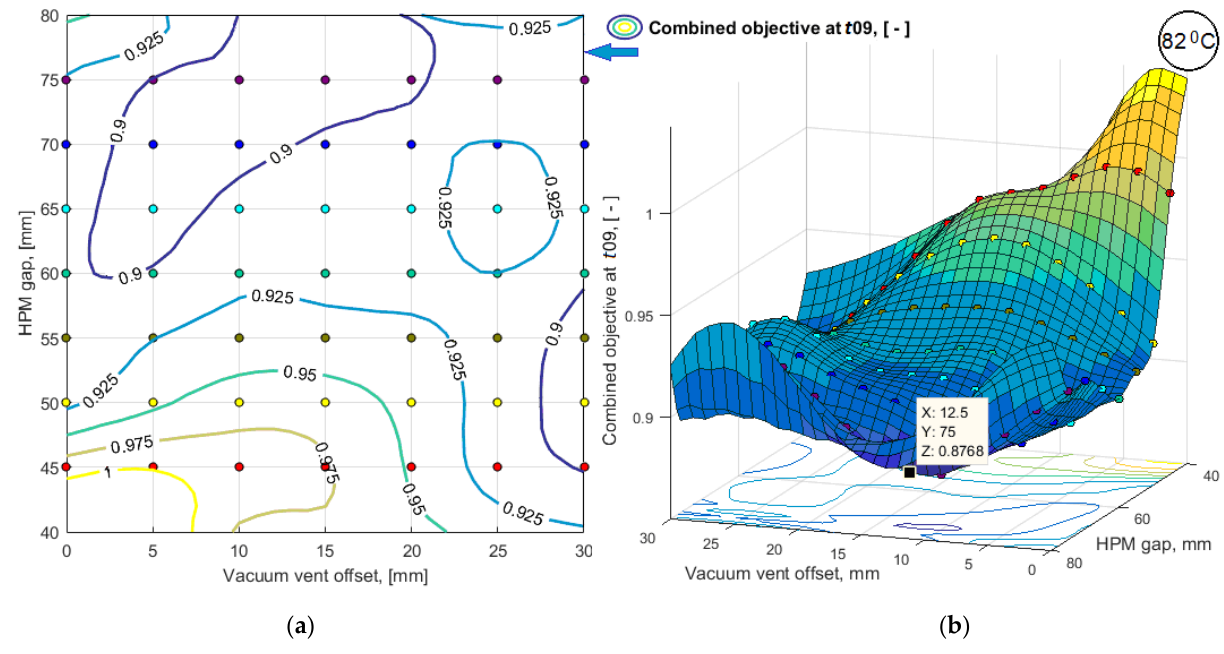
Figure 12. The response function of the predictive combined quality-reliability criterion CObj ( t 09) in the form of: ( a ) map of level lines; ( b ) smoothed 3D function.